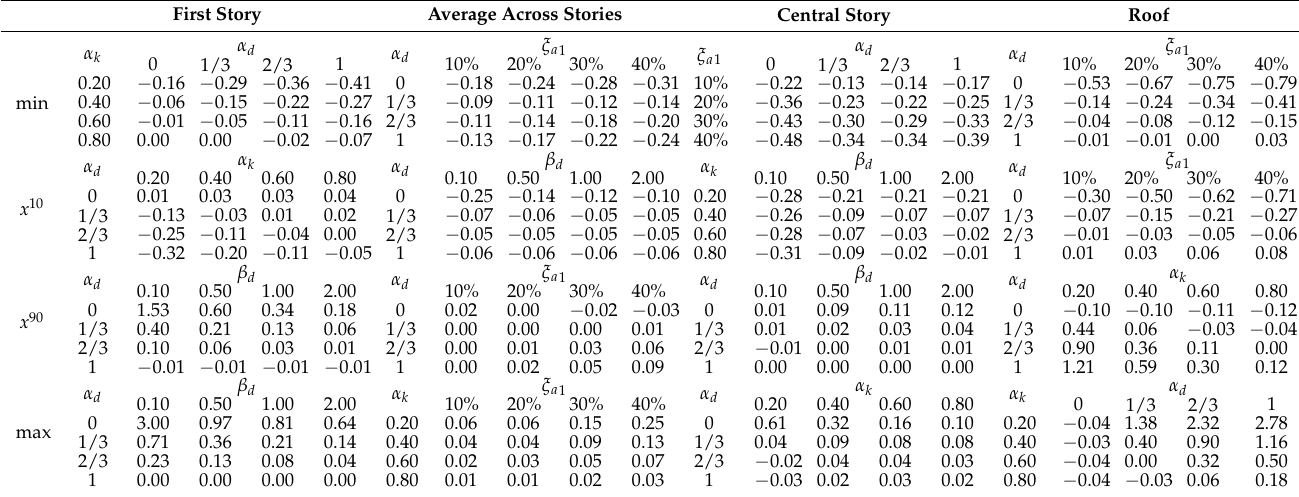
Table 6. Min, x 10 , x 90 and max for ∆ 1,error and case B0- ∞ sorted by relevant